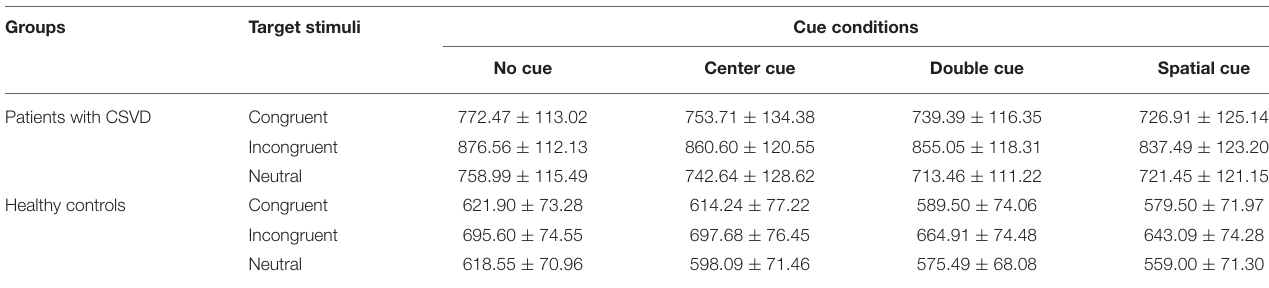
TABLE 3 | Mean reaction time (ms) under each condition for patients with CSVD and healthy controls. Groups